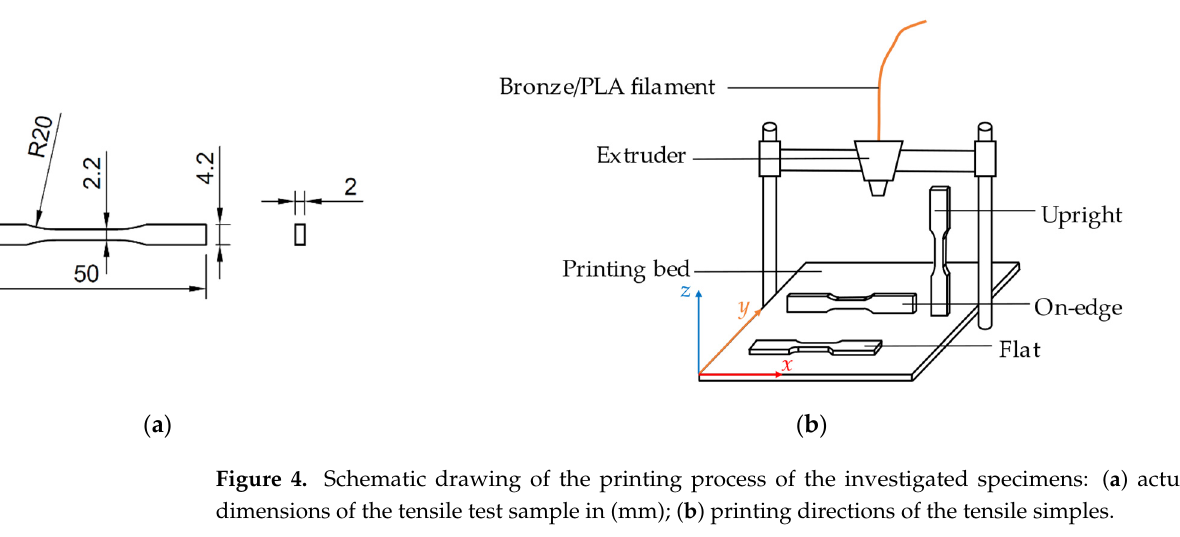
Nine different combinations were obtained by combining three printing directions and three sintering directions (see Table 3 for details).